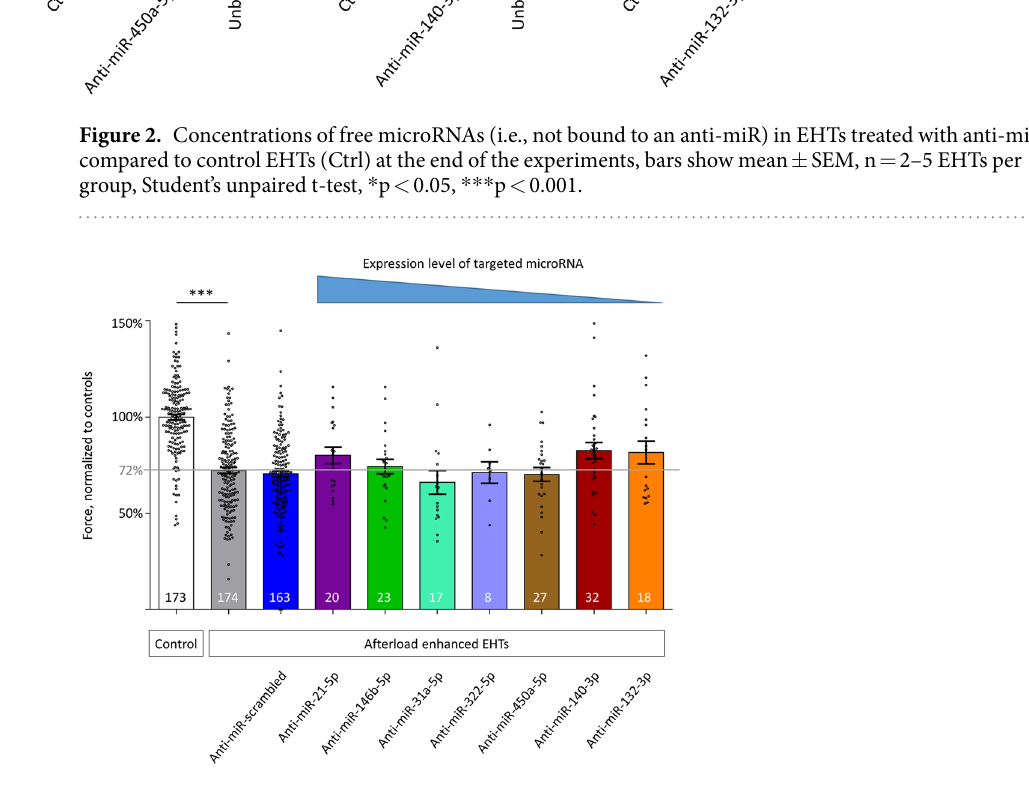
Figure 3. Contractile force of control EHTs, AE-EHTs, and AE-EHTs pretreated with anti-miRs. The grey line represents the average force of AE-EHTs in the absence of any anti-miR intervention, i.e. 72% of control EHTs. Bars show mean ± SEM, one-way ANOVA, Dunnett’s post-test for multiple comparisons against AE, *** p < 0.001, all numbers refer to total number of EHTs per